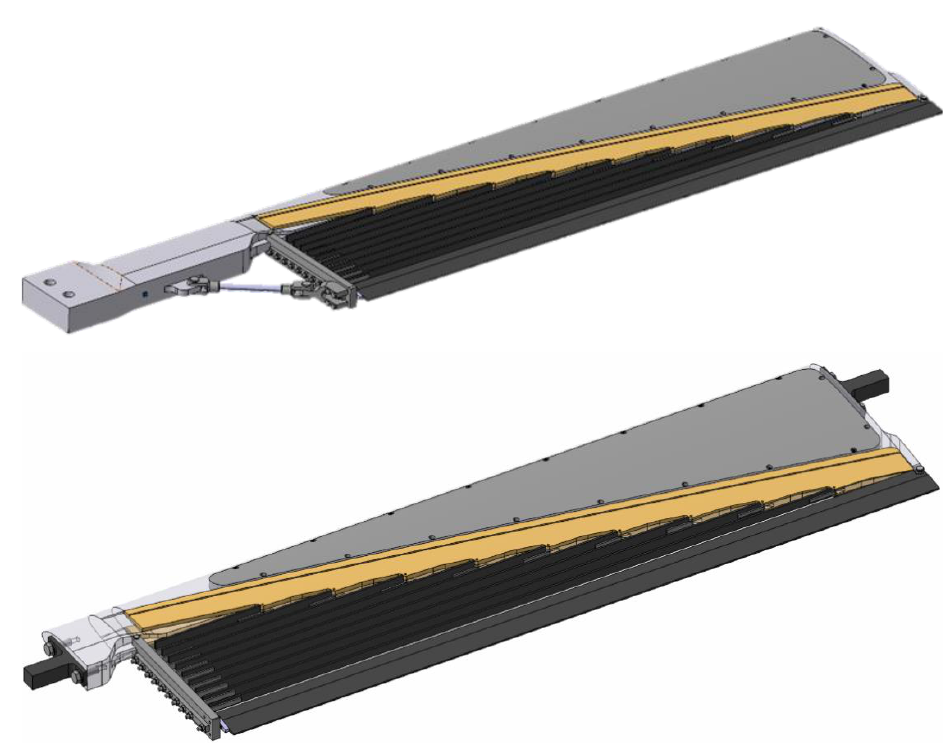
Figure 3. Modified demonstrator design with GFRP auxiliary spar for attachment of the elastic skin.